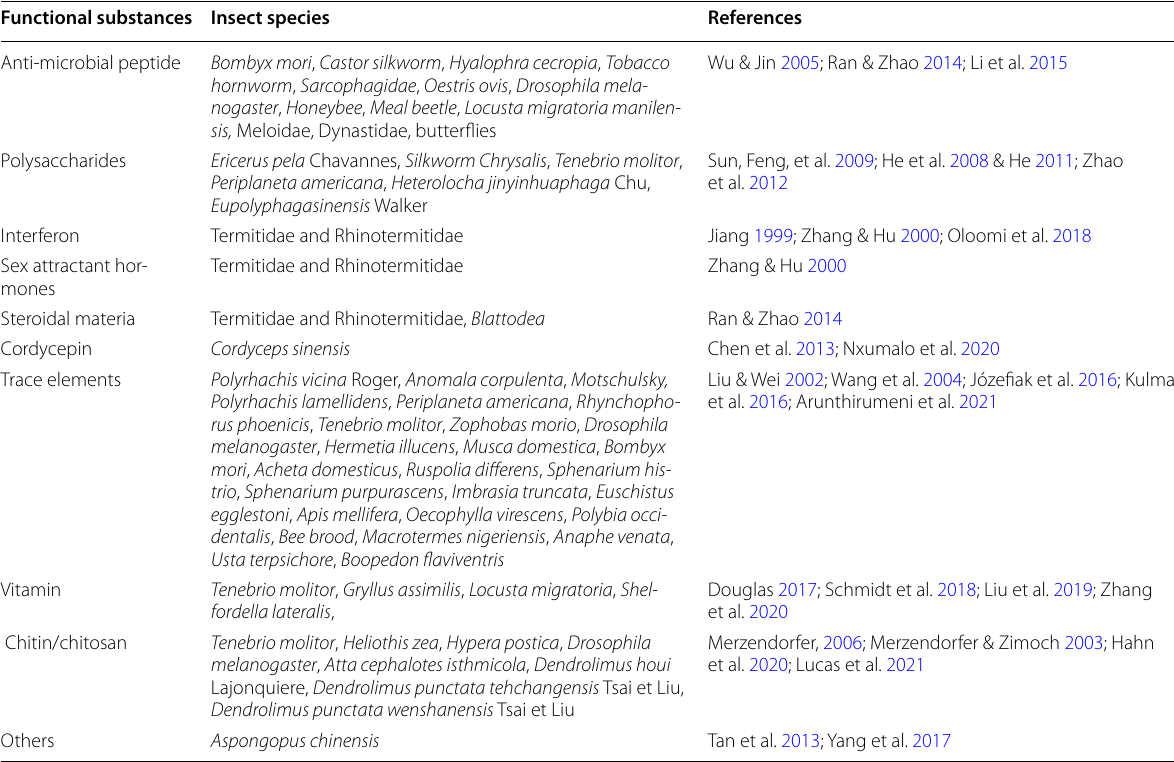
Others - some valuable edible insects are of great value to human health, but these important effects have not been identified in relation to the specific substance